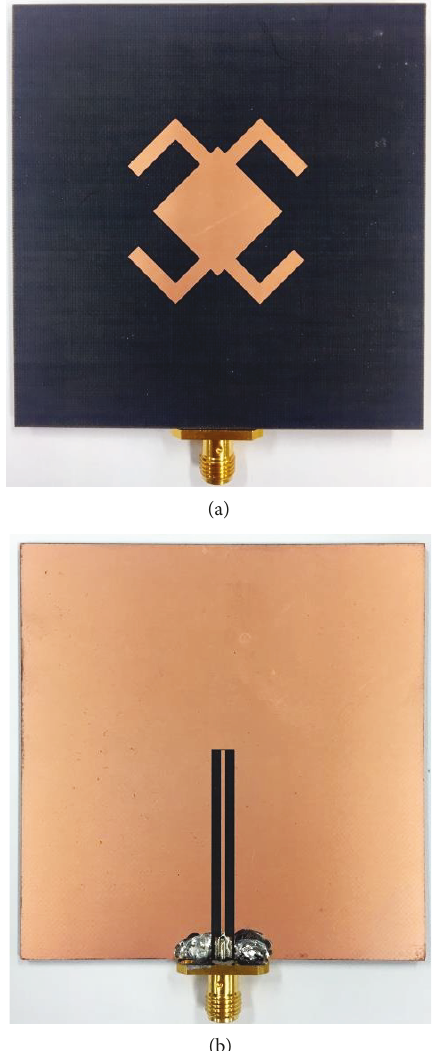
Figure 8: Picture of the fabricated antenna: (a) top layer and (b) bottom